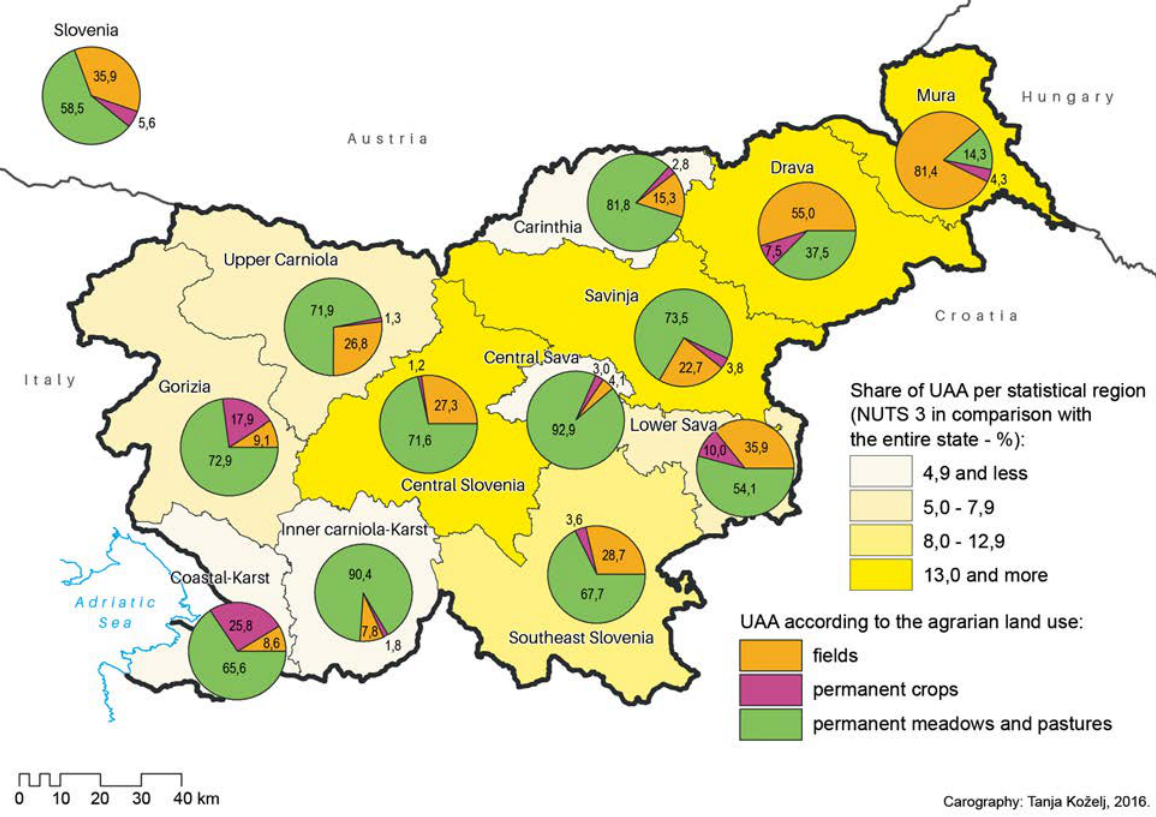
Fig. 1. Utilised agricultural areas in Slovenia (according to the NUTS 3 level). Sources: SOrS 2010; The Surveying and Mapping Authority of the rS